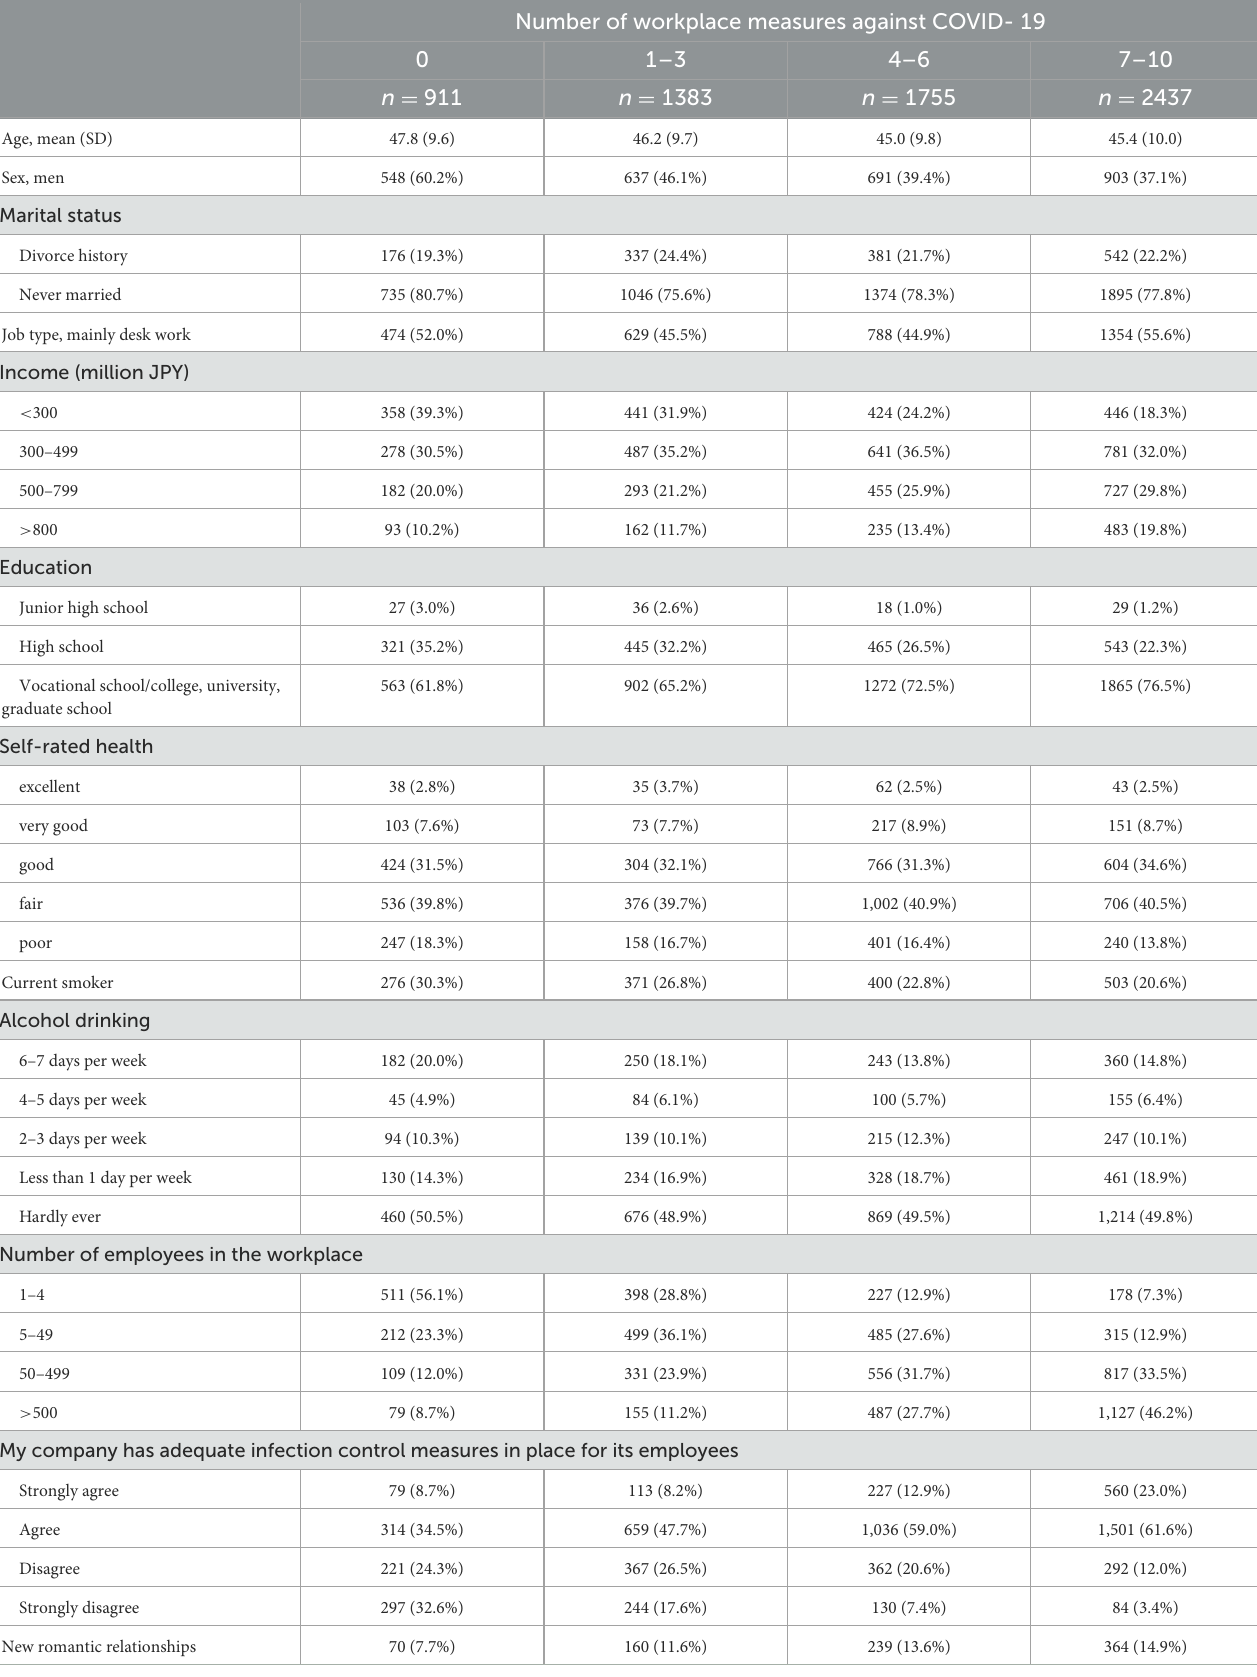
TABLE 1 Characteristics of subjects according to the number of workplace measures against